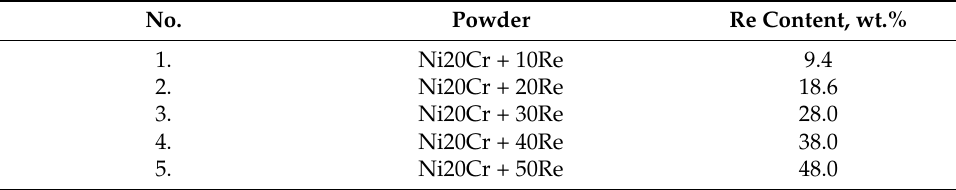
Figure 3. ( a ) Changes in a cell parameter in relation to rhenium content in powder, ( b ) changes in cell parameter in relation to rhenium content in powder. Table 3. Rhenium content in Ni20Cr + xRe powders.